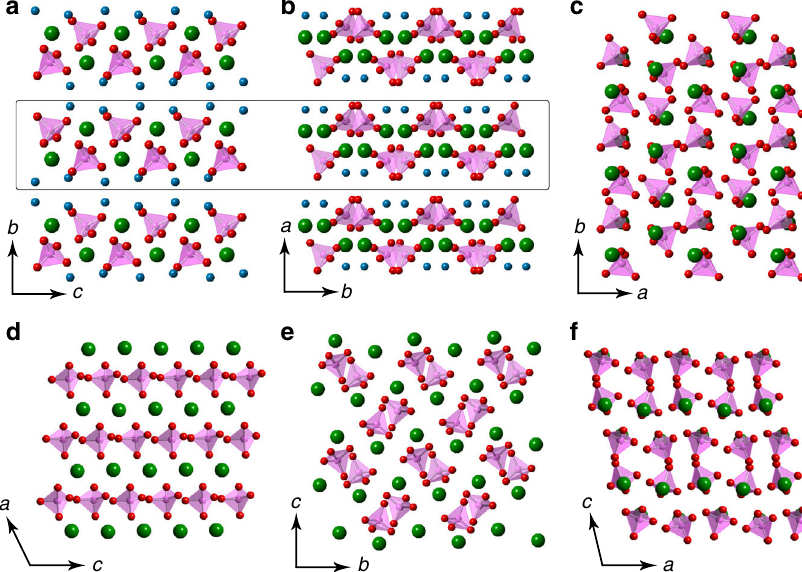
Fig. 2 Structural comparison of DCPD, DCPM and DCP. The crystal structures of DCPD ( a ), DCPM ( b ), and DCP ( c ) viewed along a , c, and c- axes, respectively. The layers in DCPD and DCPM are marked in ( a ) and ( b ) and are distinctly different in their structures, as seen in views perpendicular to each of the layers presented in d and e , respectively. f Shows the structure of DCP viewed along the b -axis. In the fi gures, magenta represents P; green: Ca; red: O of the HPO 4 ion; blue: O of the water molecules (H atoms are not shown).